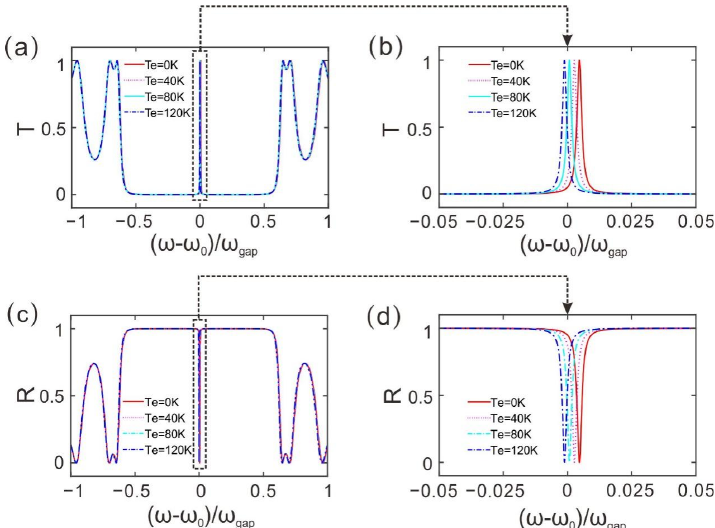
Figure 2. ( a , c ) Transmittance and reflectance, respectively, varying with the normalized frequency at different temperature values. ( b , d ) Local magnifications of transmittance and reflectance, respectively, varying with the normalized frequency at different temperature values. (The number of periods for N = 3).